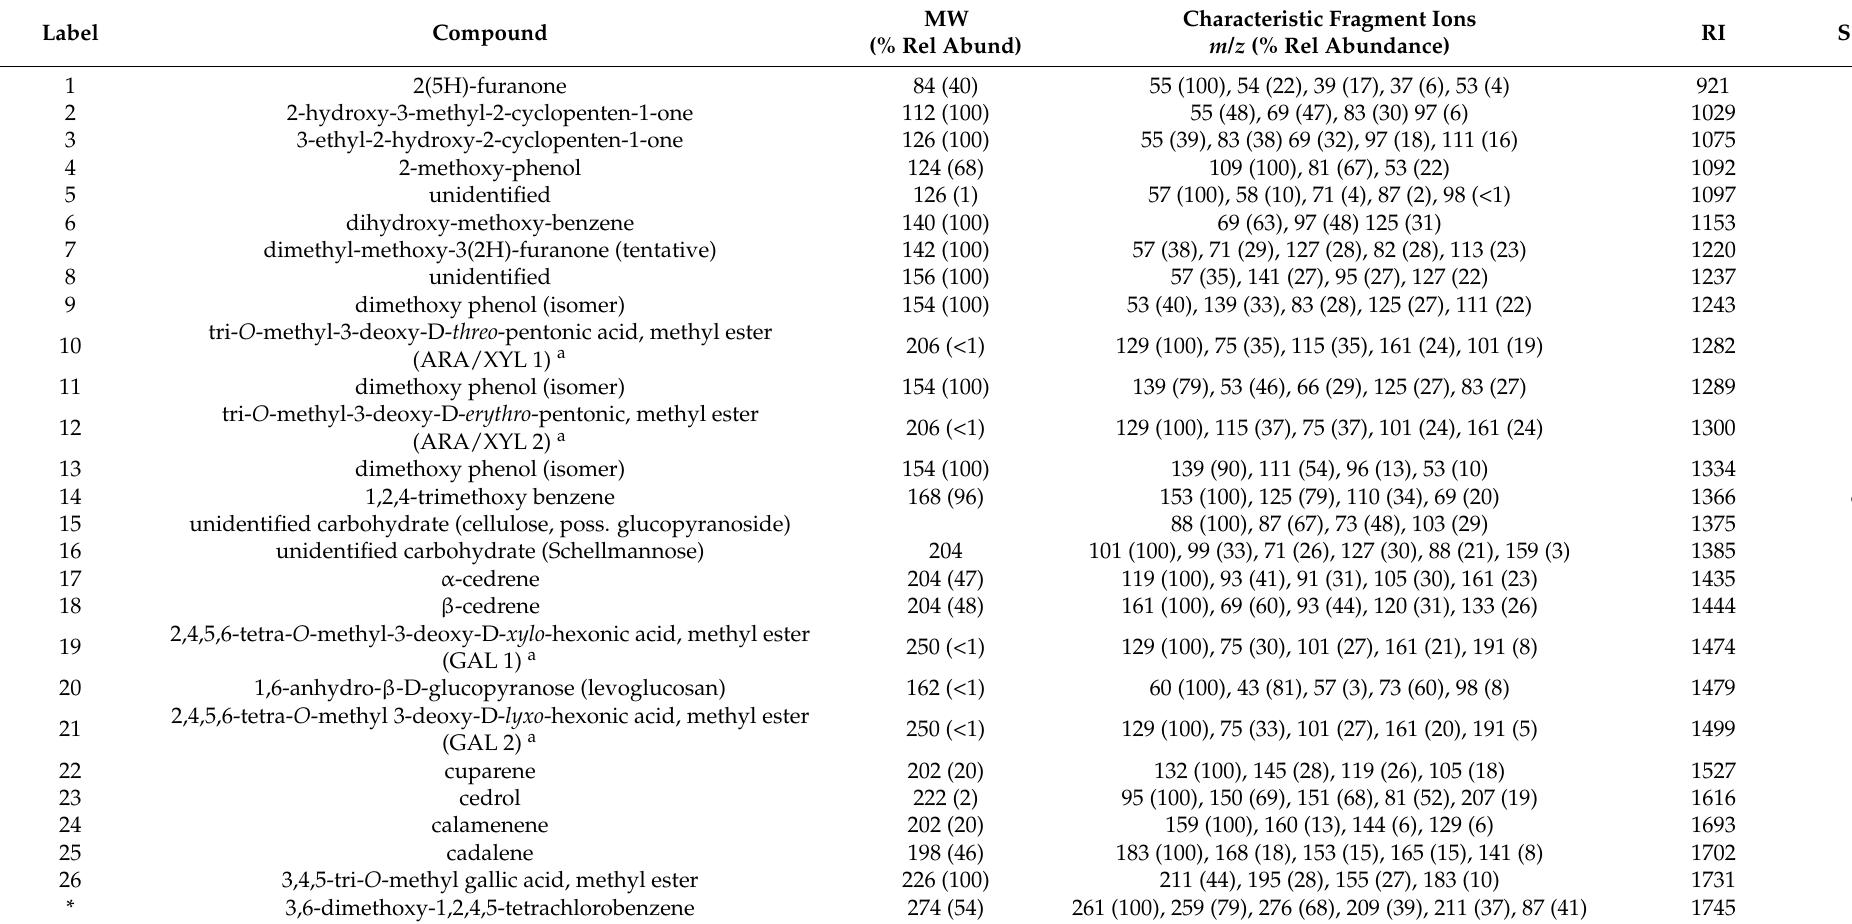
Table 1. List of compounds corresponding to the labelled peaks in Figures